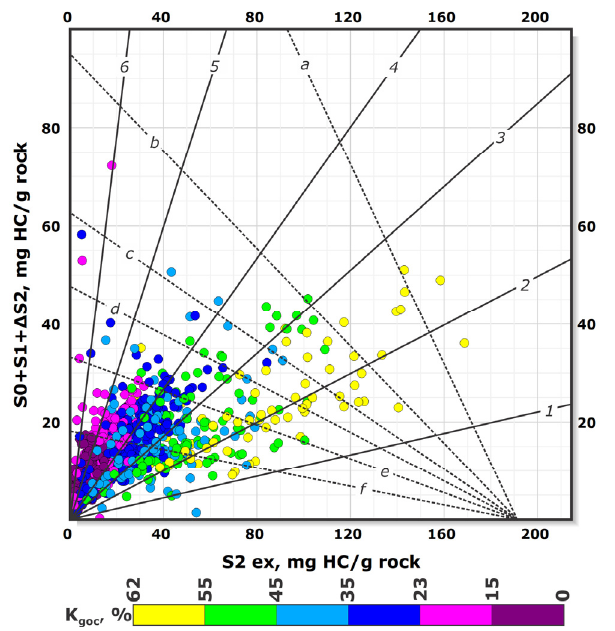
Figure 5. S0 + S1 + Δ S2 − S2 ex diagram for the studied samples. The color indicates the proportion of generative kerogen K goc . The calculated maturity trends are drawn as solid and dashed lines. Solid lines illustrate the different degrees of realization of the kerogen generation potential (1 − S2 ex /S2 0 ): 1—0.1; 2—0.2; 3—0.3; 4—0.4; 5—0.6; 6—0.8. Dashed lines limit the different percentage of fluid loss K loss : a —0%; b —52%, c —67%, d —75%, e —85%, f —92%.